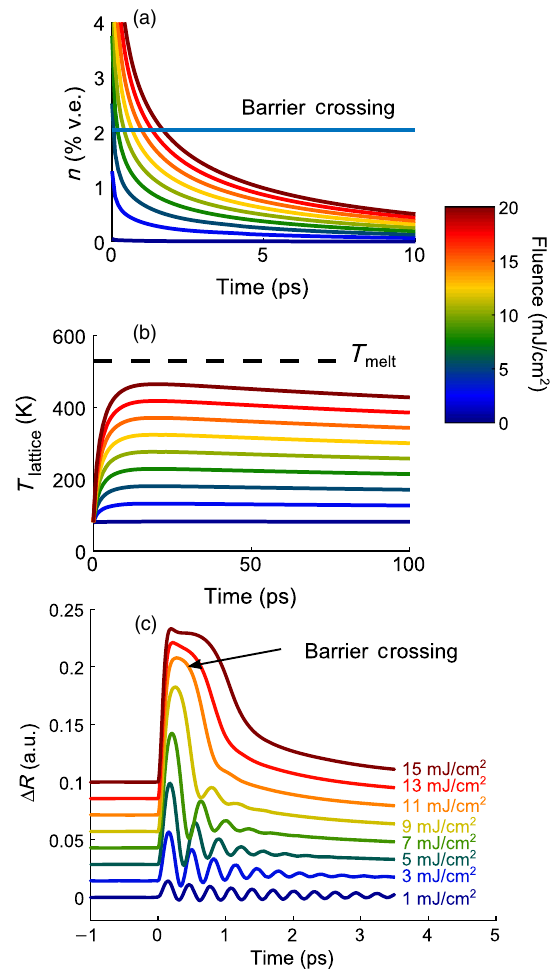
FIG. 4. Extended two-temperature modeling in